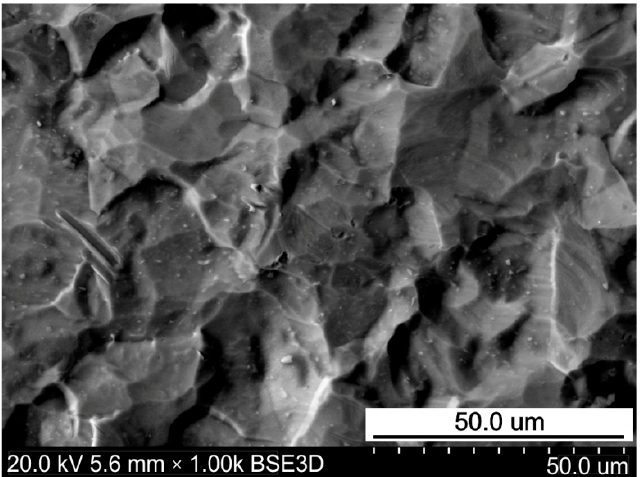
Materials 2021 , 14 , x FOR PEER REVIEW Figure 9. SEM micrograph of the as-received surface. Figure 9. SEM micrograph of the as-received surface.